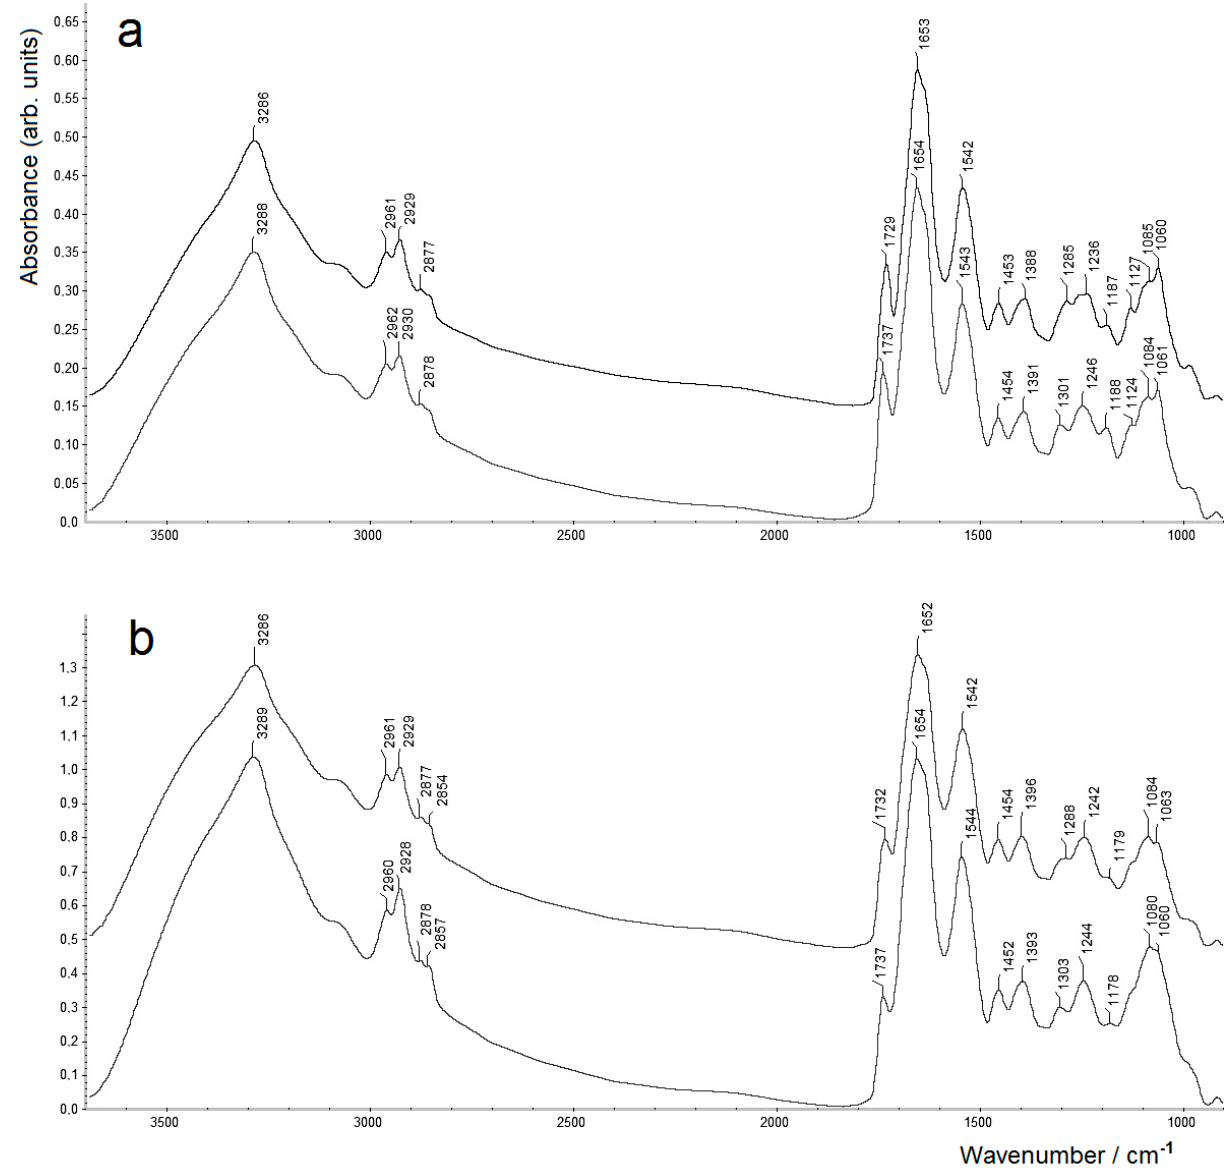
Figure 1. Transmission FTIR spectra of dry bacterial biomass of Azospirillum baldaniorum Sp245 ( a ) and A. brasilense Sp7 ( b ) measured with grinding (upper spectra) or without grinding (lower spectra). The upper spectra are vertically shifted from the baseline (zero absorbance) for clarity.